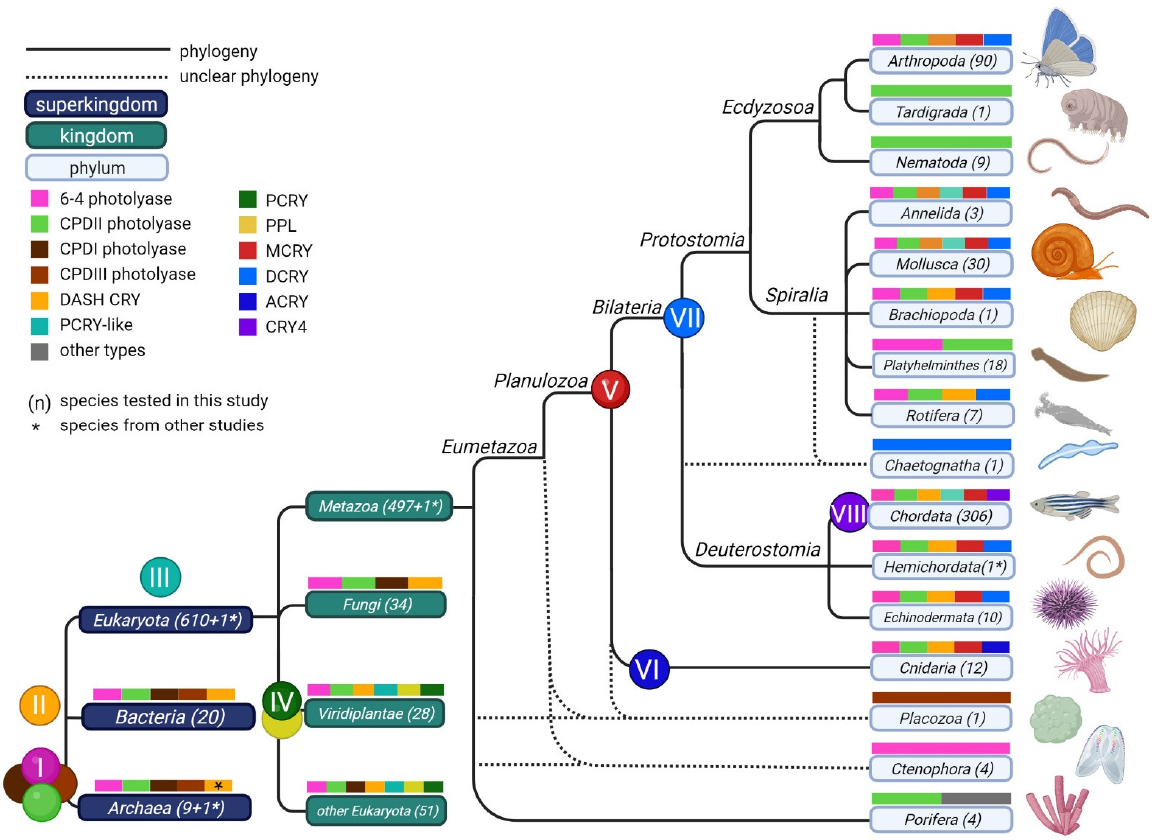
Figure 7. The origin of the CRY/PL members. (I) All three photolyases 6-4, CPDII and CPDI/III are found in all three domains of Eukaryota, Bacteria and Archaea. (II) DASH-CRY is mainly found in Eukaryota and in Bacteria. However, one archaeon is known to have DASH-CRY as well. (III) In eukaryotes, the PCRY-like protein arose next. It is found in all kingdoms except fungi. We assume that it has been lost in the fungi studied. (IV) Origin of PCRY and PPL in some algae and in Viridiplantae. (V) Origin of MCRY, which occurs in both Cnidaria and Bilateria. Its origin is therefore attributed to planulozoans. (VI) Origin of ACRY in certain cnidarians. (VII) Origin of DCRY, which occurs only in Bilateria, but in both Deuterostomia and Protostomia. (VIII) Origin of CRY4 in some chordates. The number of organisms tested is shown in parentheses next to the taxonomy name. The archaeon Halorhabdus utahensis and the hemichordate Ptychodera flava (both marked with *) were investigated in the studies by Mei and Dvornyk (2015) [19] and Kotwica-Rolinska et al. (2021)